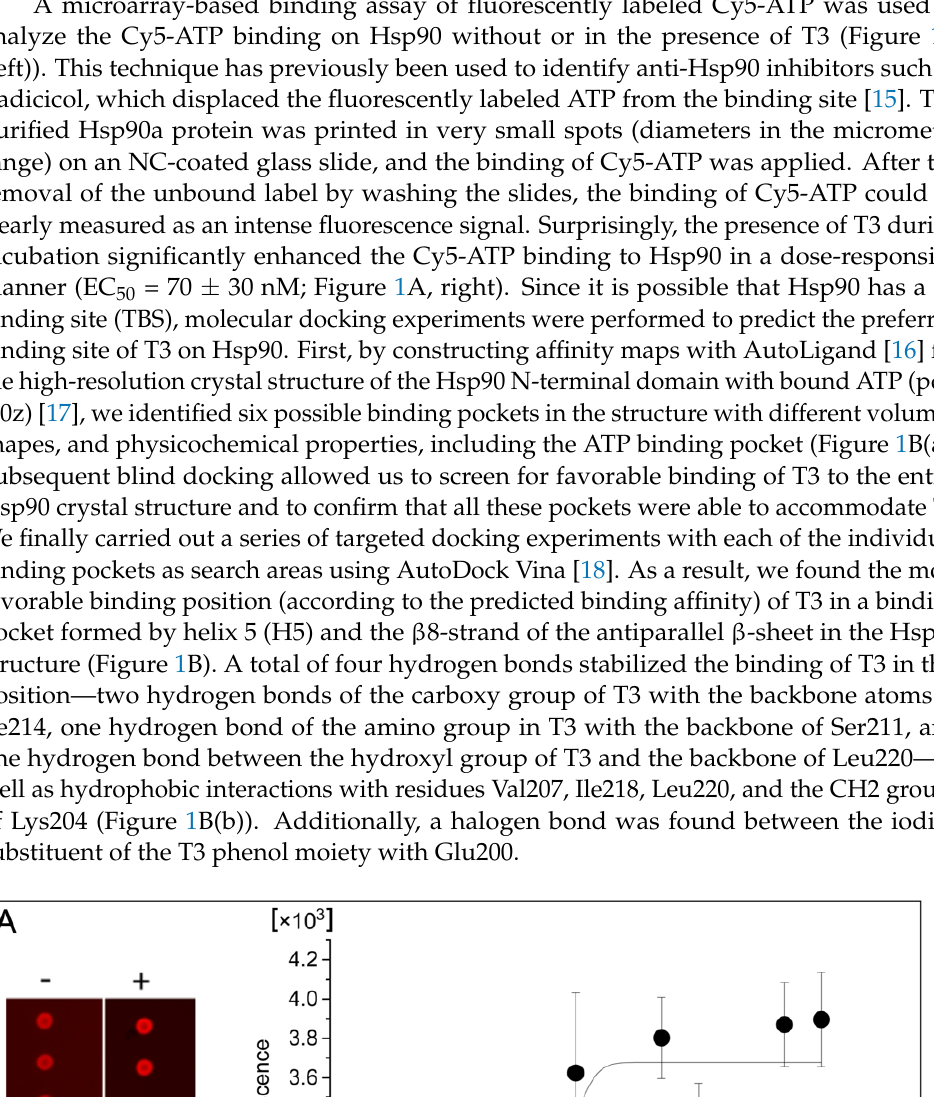
Figure 1. ( A ) Microarray-based analysis of T3 influence on Cy5-ATP binding on Hsp90. Monitoring of bound Cy5-ATP on Hsp90 without and with T3 (left) and corresponding dose-responsive binding activity (right). ( B ) Hsp90 N-terminal domain as binding target of T3: ( a ) overview of the Hsp90 N- terminal domain with identified binding pockets (colored meshes); ( b ) interactions of T3 to the resi- dues of the binding pocket; ( c ) dose-responsive activity of T3 interaction on Tyr1 peptide by mi- croscale thermophoresis analysis (MST). The dose-responsive fittings were performed with function y = A 1 + (A 2 − A 1 )/(1 + 10 (LOGx0 − x)× p) between the top and bottom asymptotes, with hill slope p and LOGx0 as center at indicated concentration x (inset). MST-traces of Cy5-labeled Tyr1 with increasing concentrations of T3 are displayed in the mode of thermophoresis + T-jump. Different concentrations of T3 are indicated by different colors of traces. Laser-induced temperature changes for F cold were applied from − 1 to 0 s, and for F hot , from 4 to 5 s. A control experiment with a bacterial HtpG from